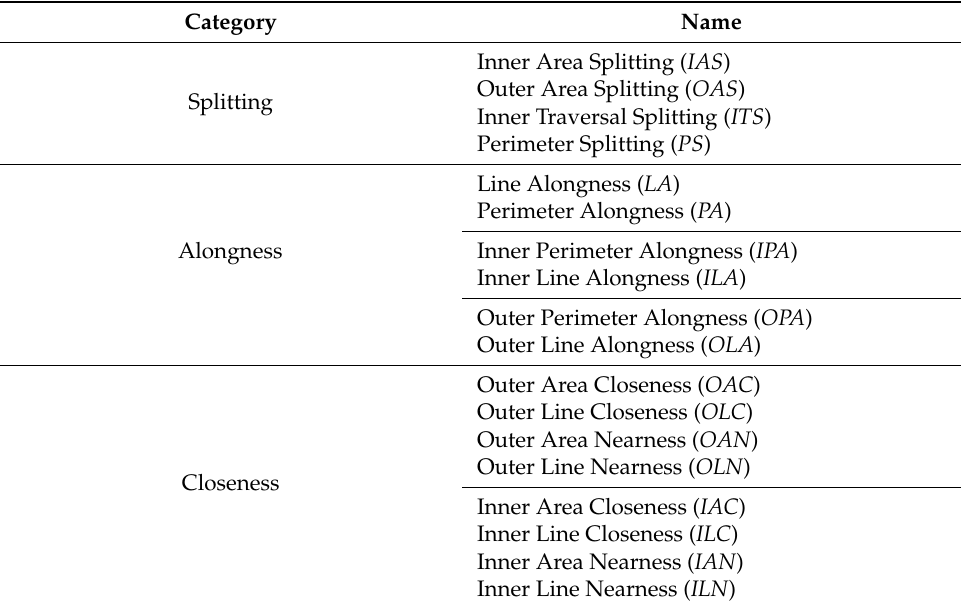
Table A1. Abbreviations of the 18 explanatory variables.